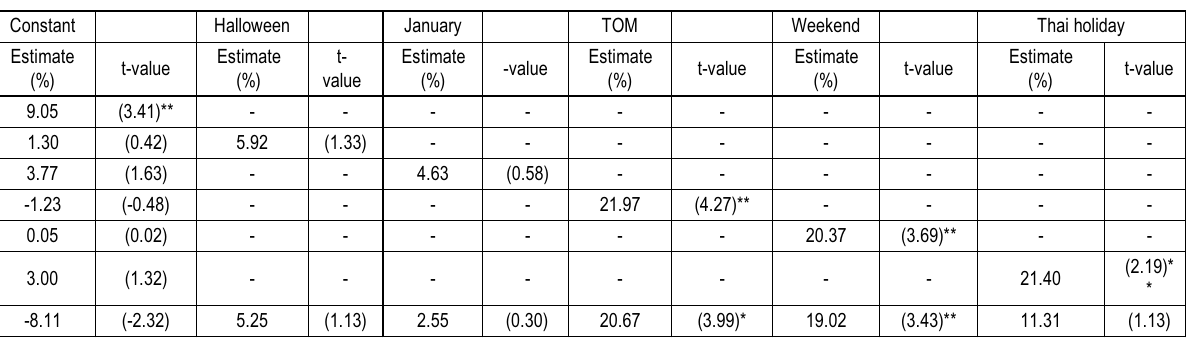
Table 1.Calendar effect on Thailand equity risk